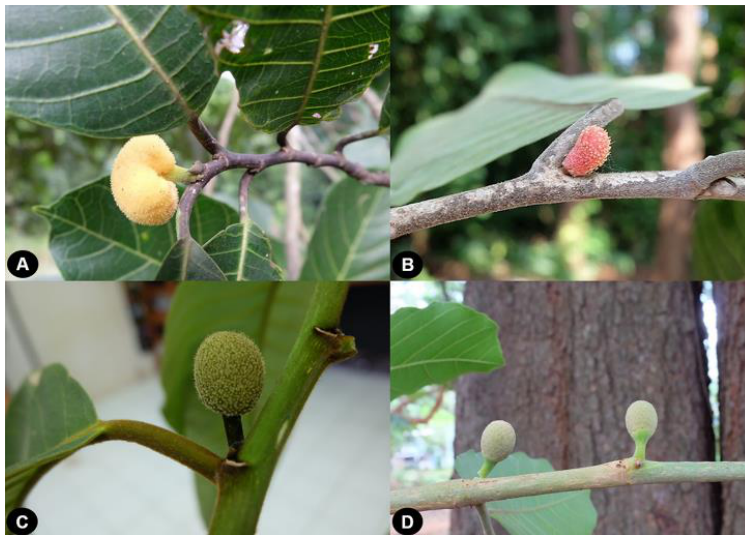
Figure 1. Inflorescences of A. lacucha and A. thailandicus . ( A ) staminate inflorescence of A. lacucha , subglobose ( B ) staminate inflorescence of A. thailandicus , obovoid ( C ) pistillate inflorescence of A. lacucha , obovoid ( D ) pistillate inflorescence of A. thailandicus , obovoid. Table 1. The main differentiating characters between A. lacucha and A. thailandicus . Characters